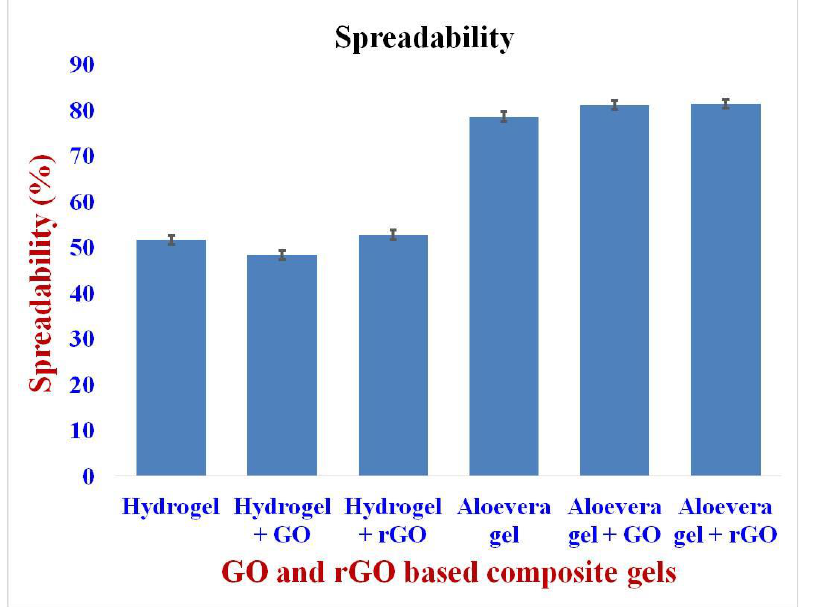
Figure 5. Spreadability of GO and rGO-based composite gels. Aloe vera gels are more spreadable than hydrogels.